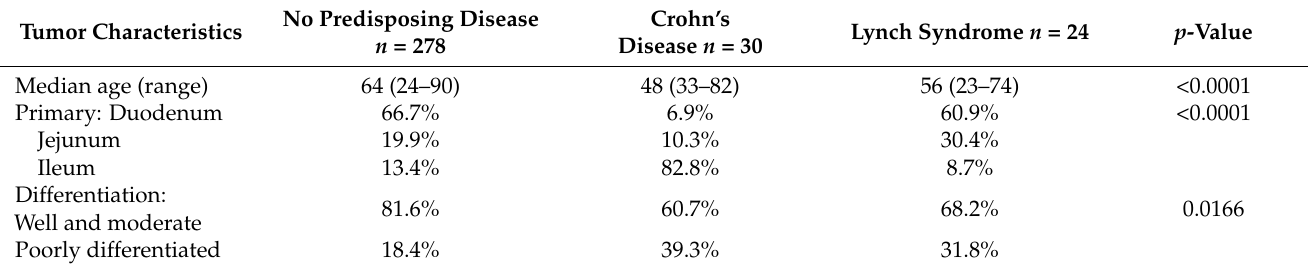
Table 2. Differences according to predisposing disease observed in the NADEGE cohort